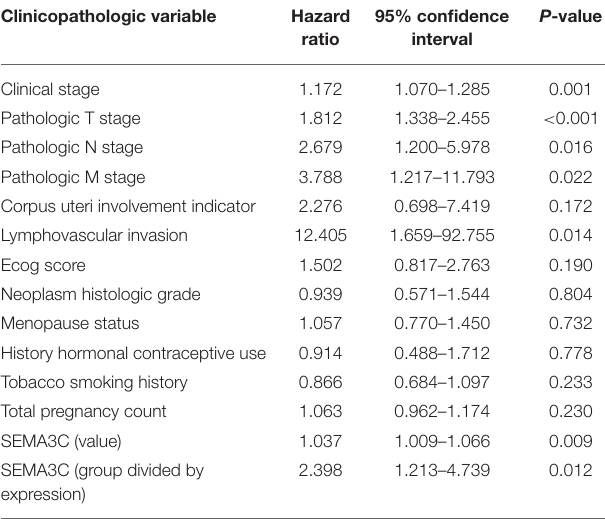
TABLE 2 | Univariate Cox regression analysis of various prognostic parameters in the TCGA patients.